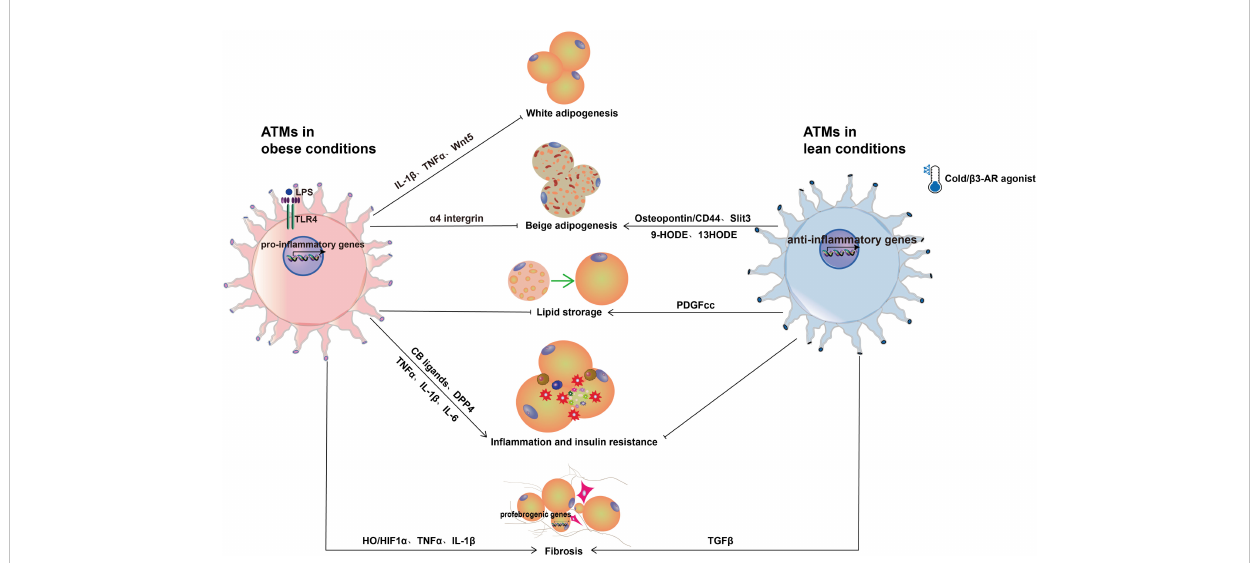
FIGURE 2 Role of ATMs in adipose tissue. In obese conditions, pro-in fl ammatory macrophages show detrimental effects on adipose tissue function such as inhibition of adipogenesis, promoting in fl ammation, insulin resistance, and fi brosis. The pro-in fl ammatory cytokines TNF- a and IL-1 b and the protein factor Wnt5a inhibit preadipocyte differentiation when released by pro-in fl ammatory macrophages. In addition, TNF- a and IL-1 b reduce the insulin sensitivity of adipocytes. Through LPS-TLR4 the LPS-induced CB ligands-CB1 signaling pathways, pro-in fl ammatory macrophages also aggravate adipose tissue in fl ammation. Moreover, macrophages secrete the enzyme DPP4, which causes both hyperglycemia and in fl ammation. In addition to inducing preadipocytes to produce abundant ECM, pro-in fl ammatory macrophages overproduce NO, which increases HIF-1 a accumulation and promotes pro fi brogenic responses in preadipocytes, resulting in adipose tissue fi brosis. In lean conditions, ATMs are anti-in fl ammatory and play an important role in the formation and activation of beige adipocytes. In response to cold stimulation, ATMs polarize to an alternative activation state and promote the biogenesis of beige adipocytes via macrophage-secreted cytokine Slit3 and a sympathetic neuron-adipocyte signaling axis. Similar to cold stimulation, b 3-AR agonists enhance the conversion of existing white adipocytes into beige adipocytes. Furthermore, b 3-AR agonists induce alternative activation of macrophages to release osteopontin and the PPAR g ligands 9-HODE and 13-HODE, which stimulates beige adipocyte